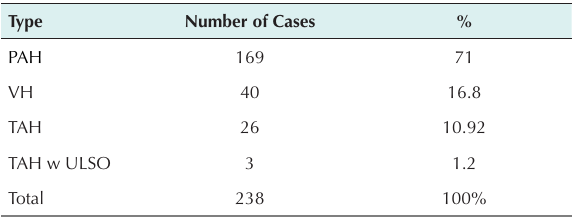
Table 1. Types of